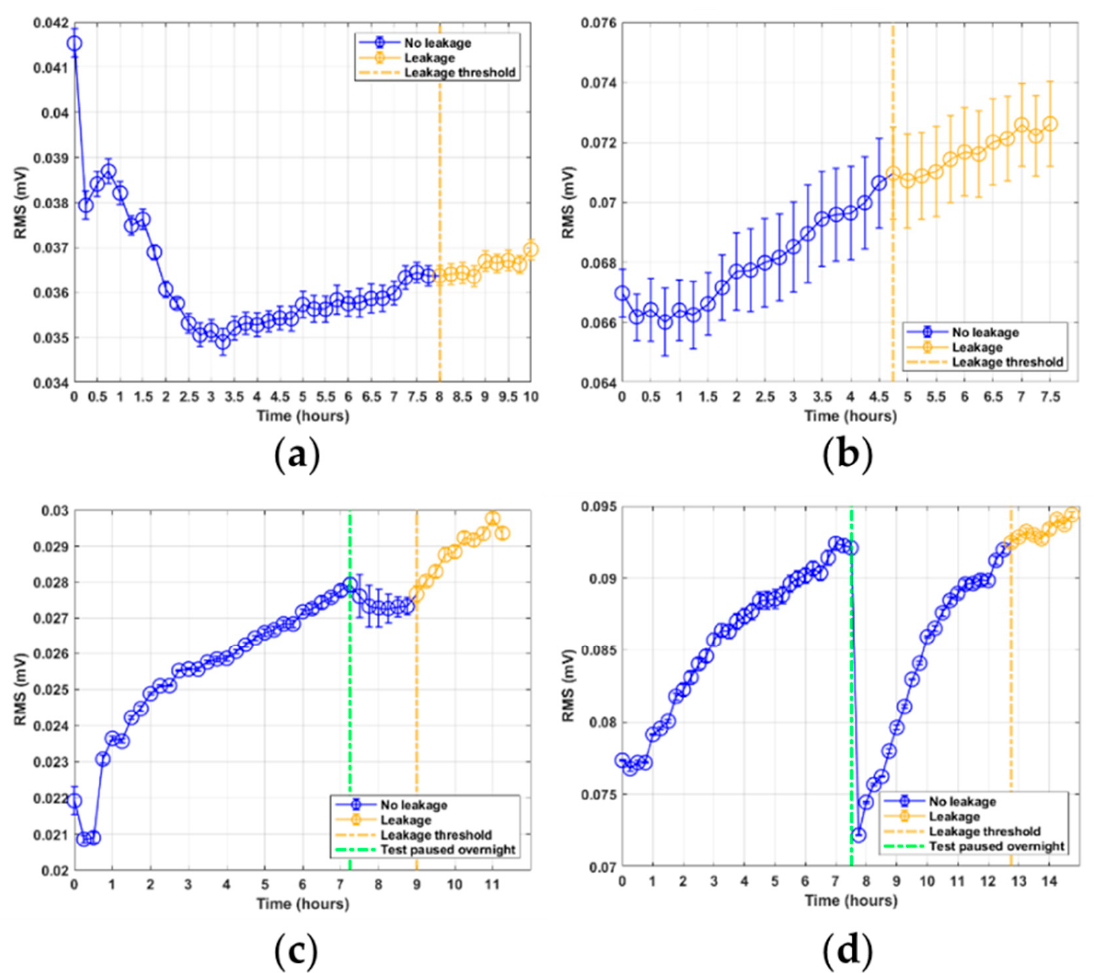
Figure 5. RMS feature results from RTF tests 1–4: ( a ) test 1; ( b ) test 2; ( c ) test 3; ( d ) test 4.